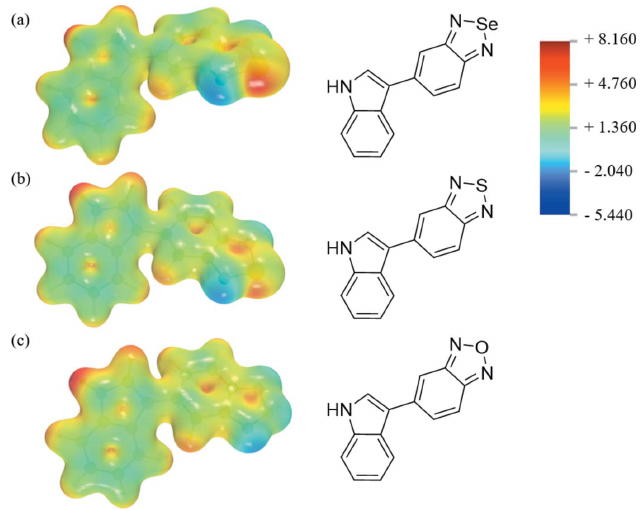
Figure 7 Computed electrostatic potential (EPS) surfaces and associated mol- ecular structures ( a ) bSe ( b ) bS ( c ) bO. The EPS color scale ranges from +8.160 volt to (cid:2) 5.440 volt.